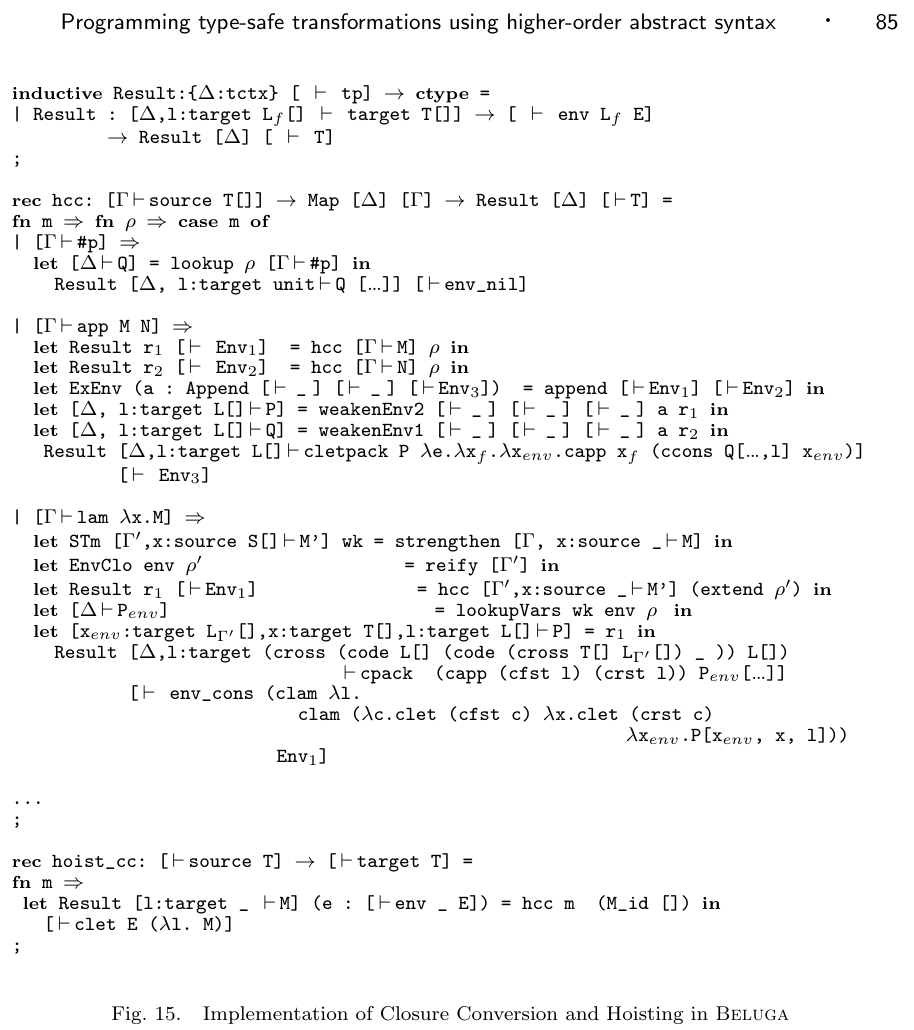
Fig. 15. Implementation of Closure Conversion and Hoisting in